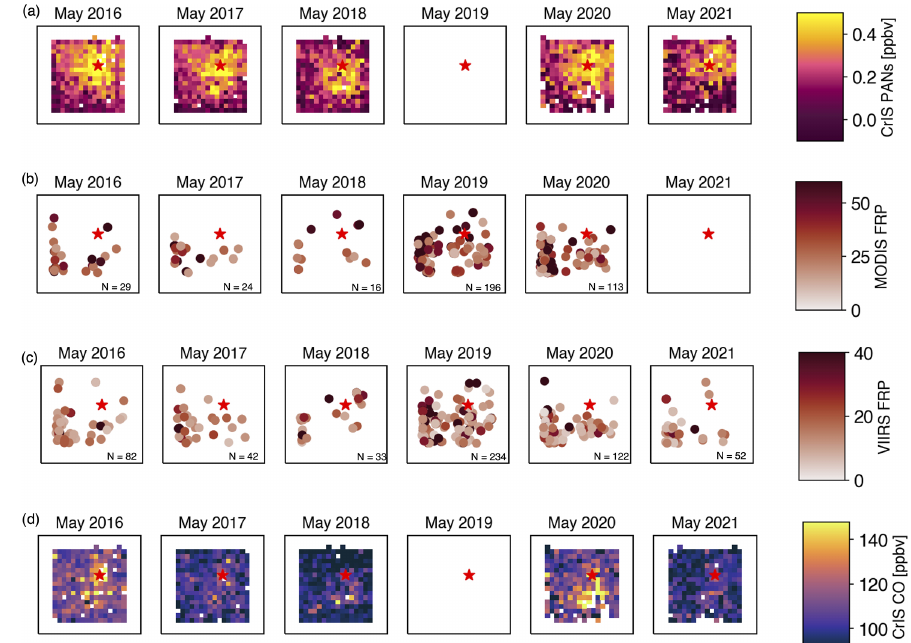
Figure 7. (a) Gridded average PANs for the month of May for the region surrounding Mexico City for multiple years. The center of Mexico City is denoted by a red star. (b) MODIS fire radiative power (FRP) for the Mexico City region, (c) VIIRS fire radiative power (FRP) for the Mexico City region, and (d) gridded free-tropospheric average CrIS CO. This is the full region of available CrIS observations (21 ◦ N, 100.9 ◦ W, 18 ◦ N, 97.1 ◦